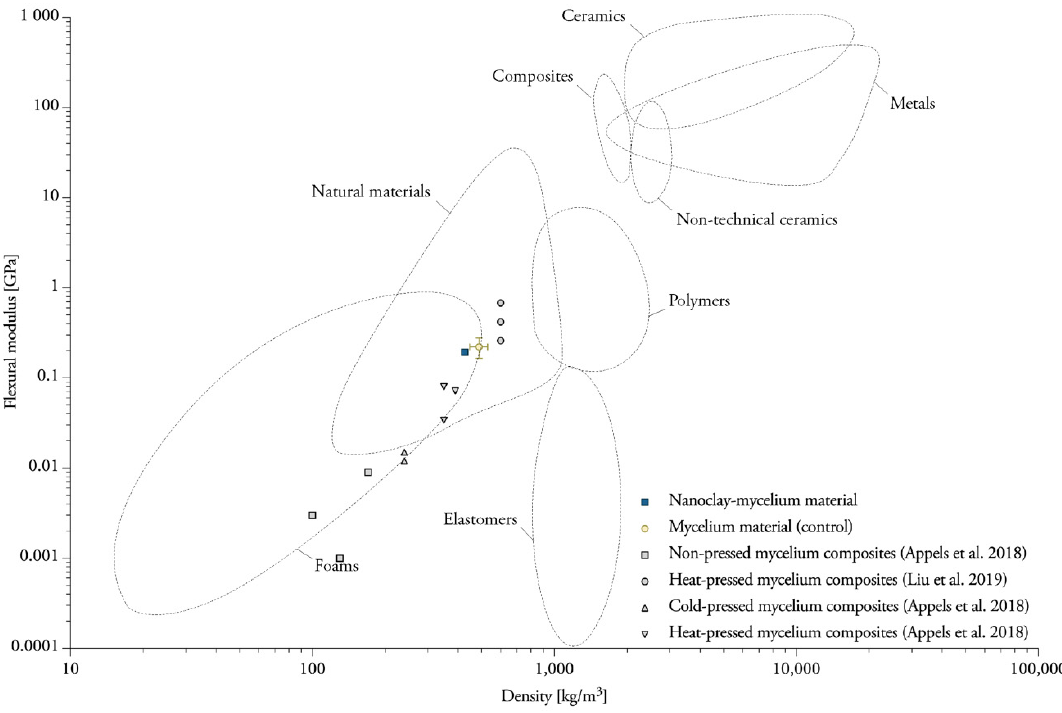
Figure 15. Overview of data on the flexural modulus for mycelium materials obtained in this and other studies. Data compiled from [3,44]. Plotted on Ashby chart for engineering materials [57].